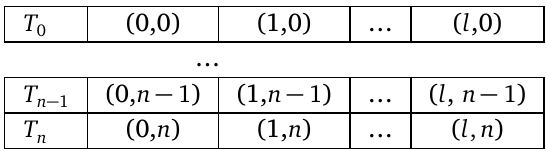
Regular expression notation in